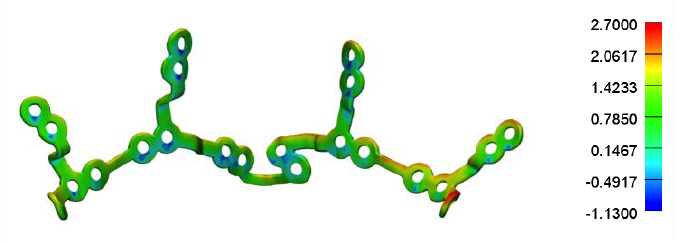
Figure 7. Plate superimposition.